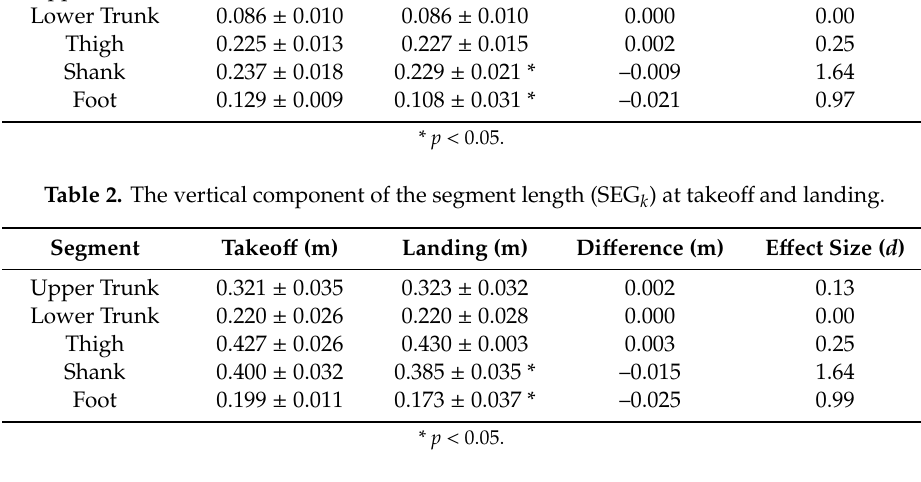
Table 3. The contribution of the di ff erence in the vertical component of the segment length (SEG k ) to the di ff erence in the whole-body center of mass (COM wb ) height (CONT k ).